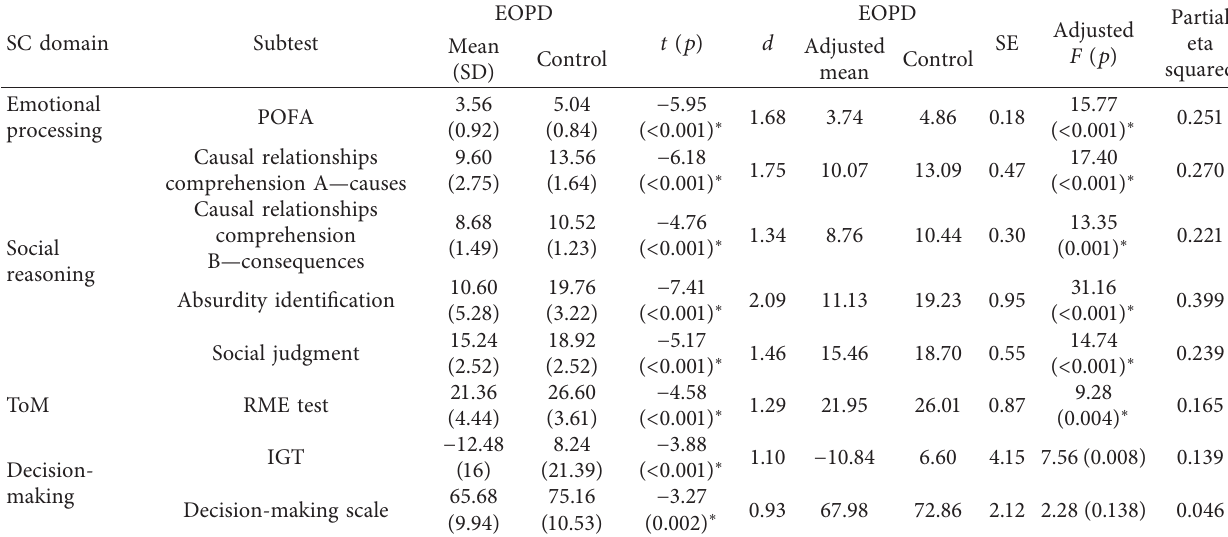
Table 3: Comparison of performance in SC between the EOPD ( n � 25) and control ( n � 25) groups before and after adjusting for overall cognitive ability.